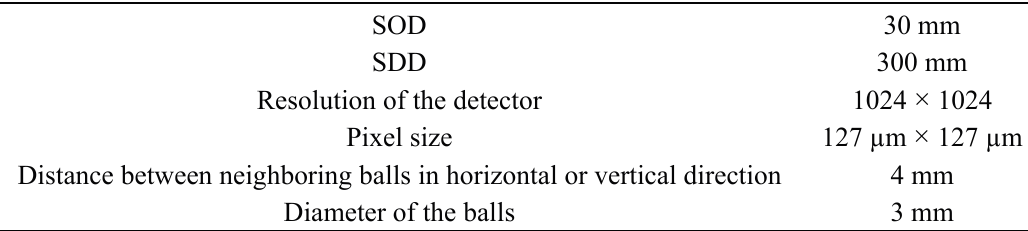
Figure 4. The procedure of calibration. Table 1. The main parameters of CT